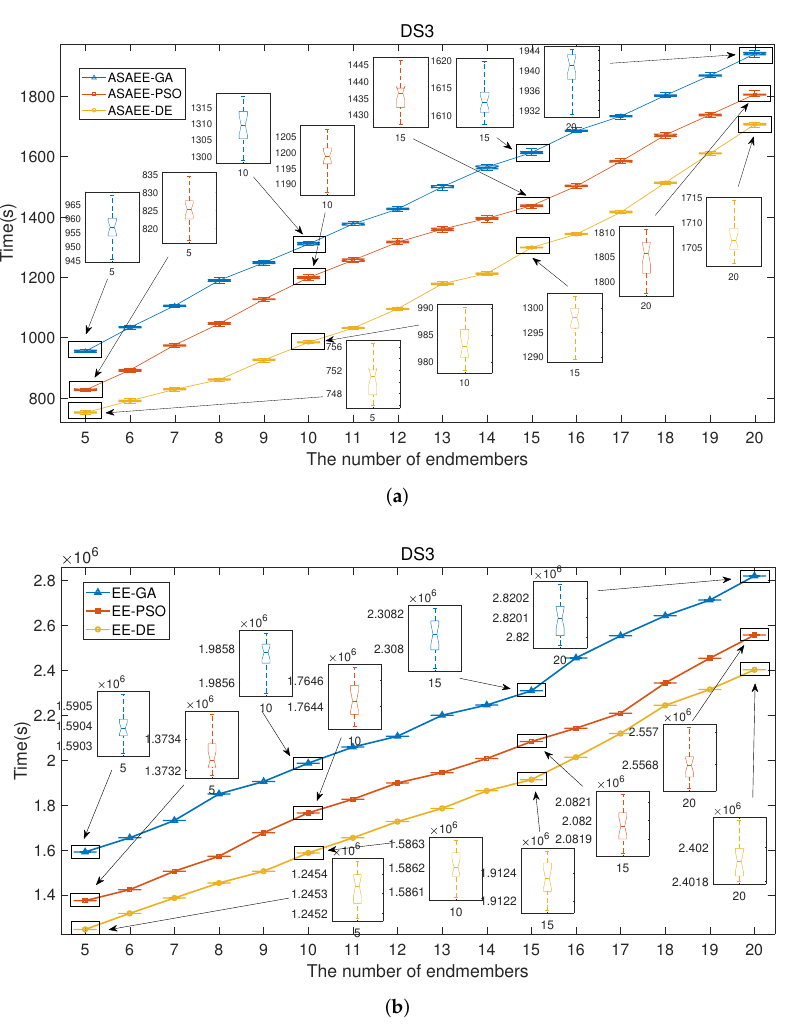
Figure 6. Comparison with and without ASAEE framework on DS3. ( a ) Methods with ASAEE framework. ( b ) Methods without ASAEE